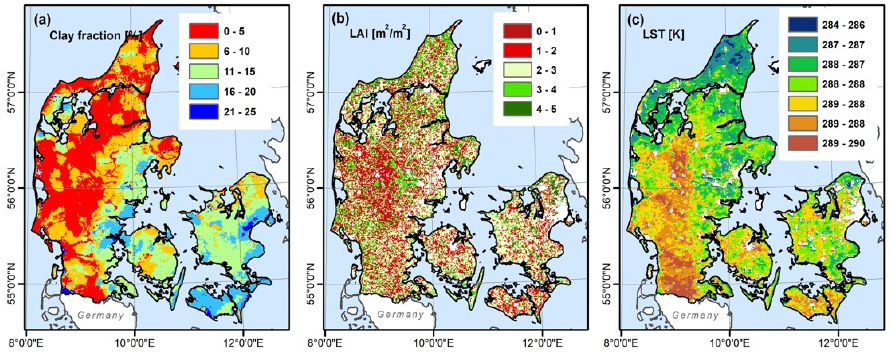
Figure 2. The grid-cell (1 km) distributed annual mean (2002–2014) maps: ( a ) clay fraction, ( b ) leaf area index LAI, and ( c ) land surface temperature LST.